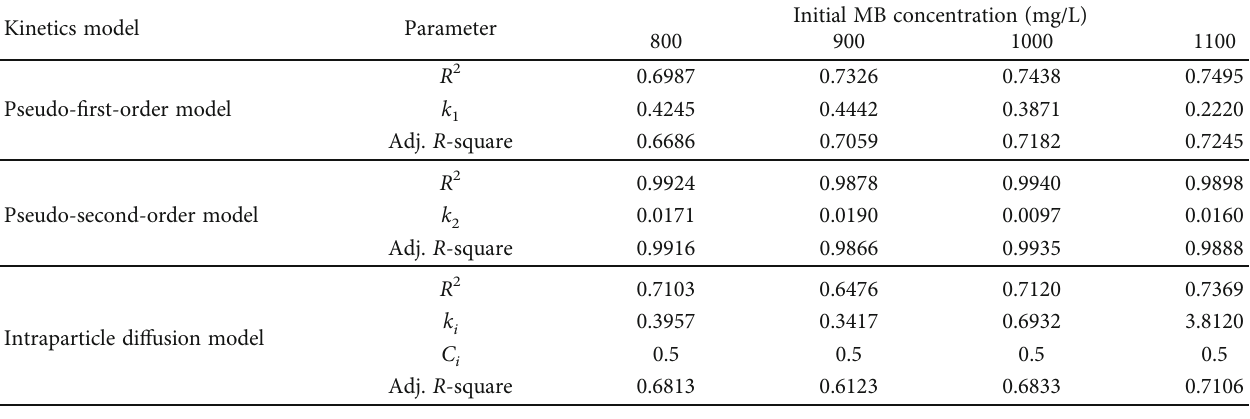
O nanosheets with concentrations of MB solutions. 2 4